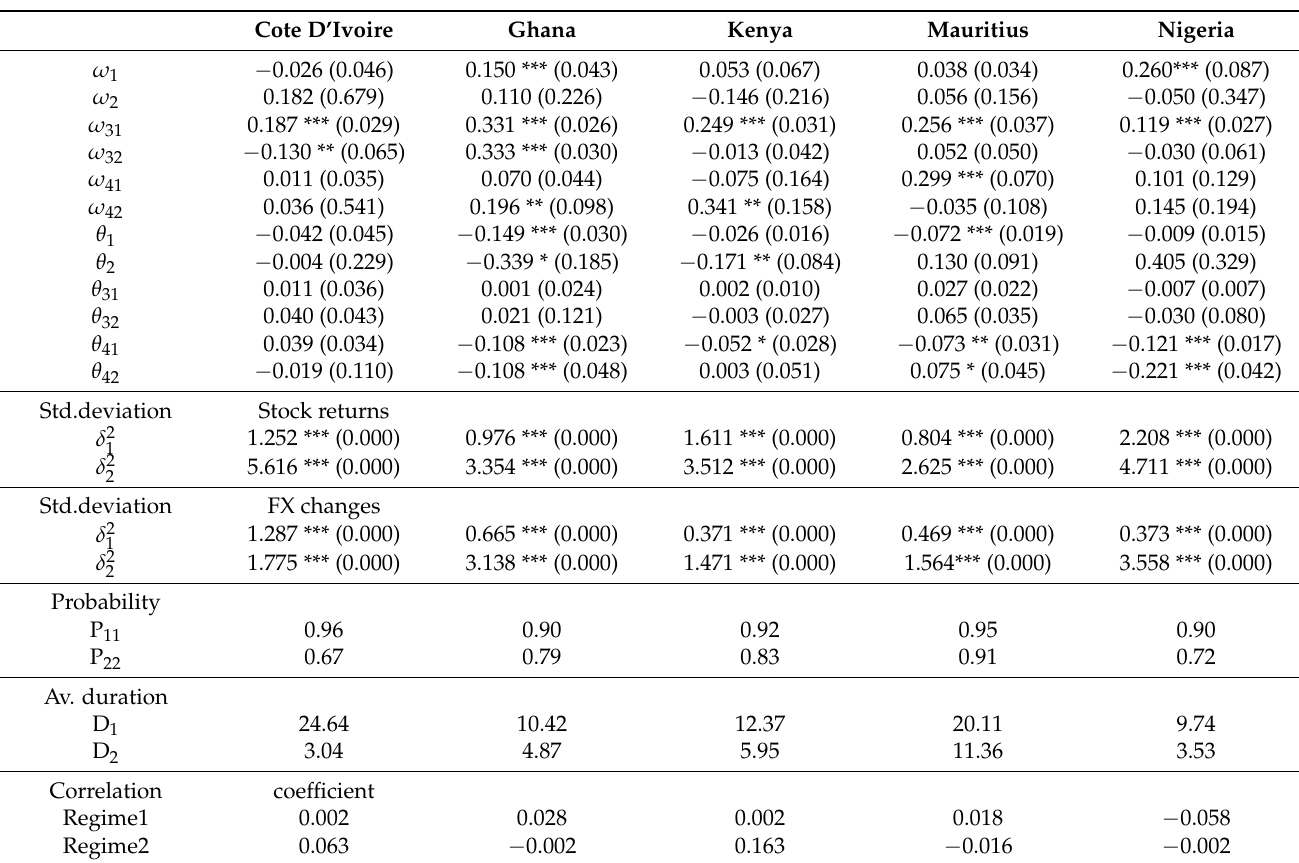
Table 10. MS-VAR model